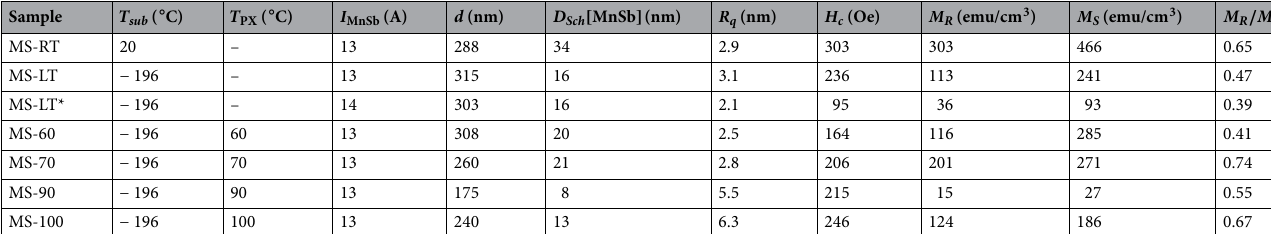
Table 1. Sample parameters: substrate temperature T sub ; sublimation temperature of the monomer precursor T PX ; electrical current I MnSb applied to the tantalum boat for the MnSb evaporation; film thickness d ; mean size of MnSb crystallites D Sch [ MnSb ] ; RMS roughness R q ; coercive force H c , remanent magnetization M R , saturation magnetization M S and corresponding M R / M S ratio at room temperature for studied